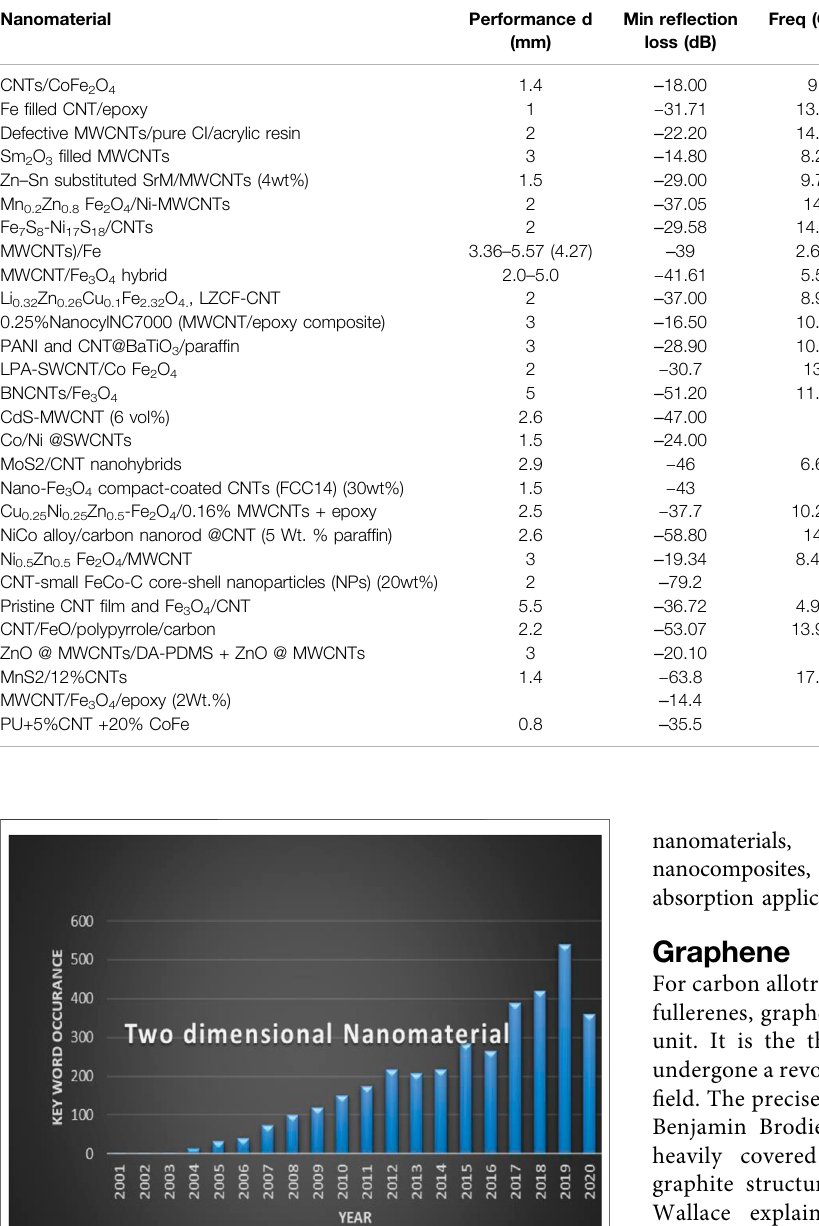
TABLE 1 | CNT-based composites for microwave absorption.